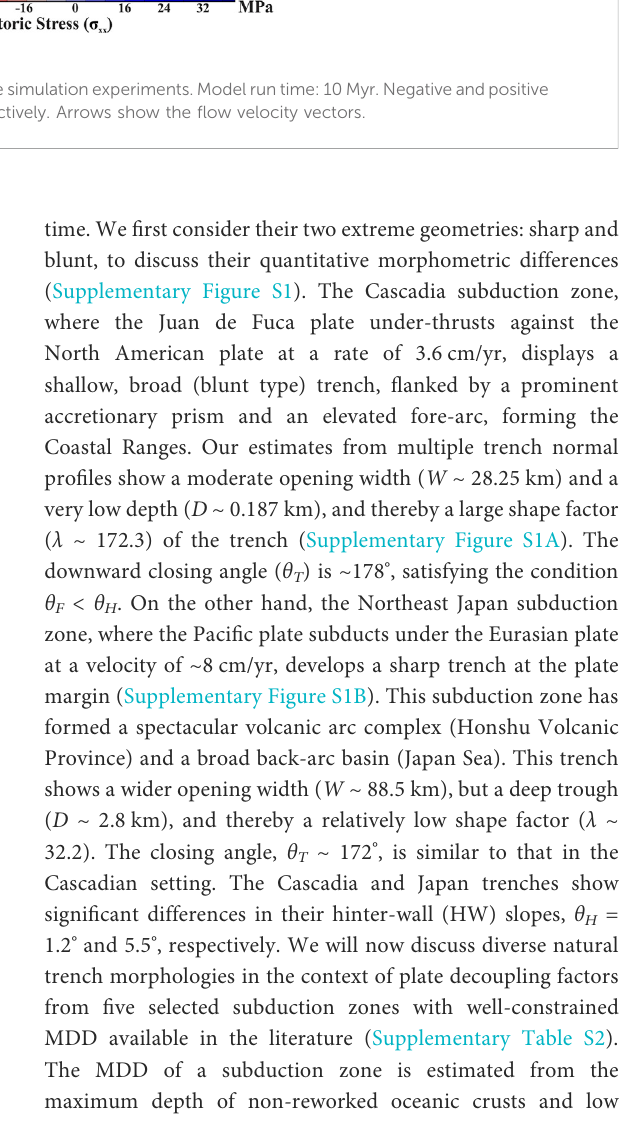
Figure 9B. The closing geometry ( θ T ) is also sensitive to Δρ * (Figure 9C), θ T ~ 128 ° at 20 Myr for Δρ * = 0.0031, which becomes < 106 ° when Δρ * = 0.0092 .